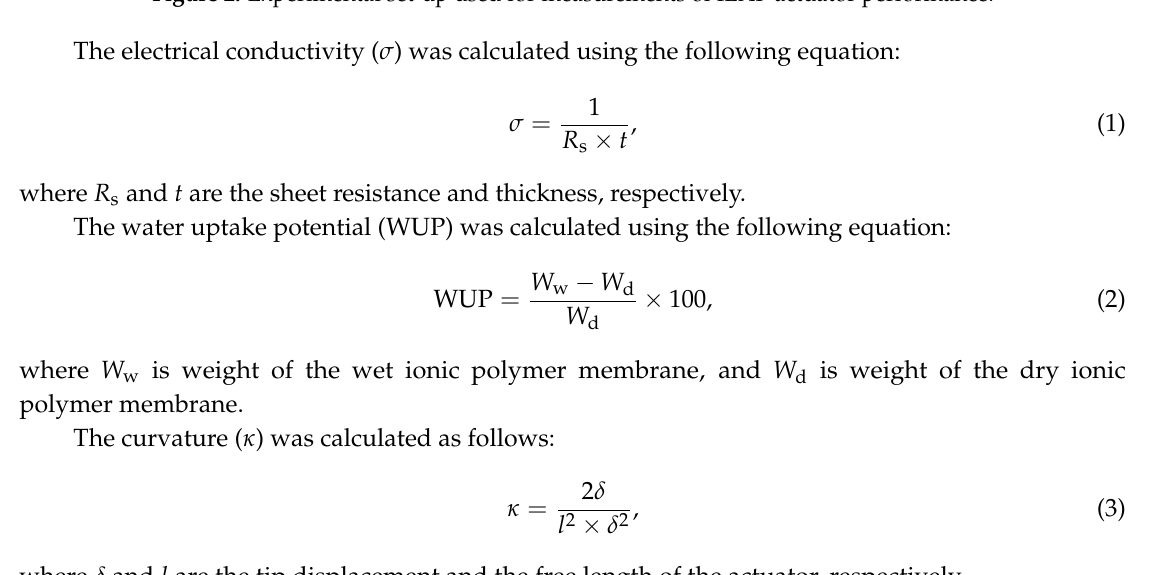
Figure 2. Experimental set ‐ up used for measurements of IEAP actuator performance.